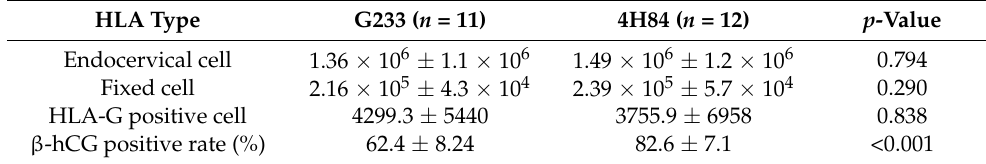
Table 2. Trophoblast contents and detection of β